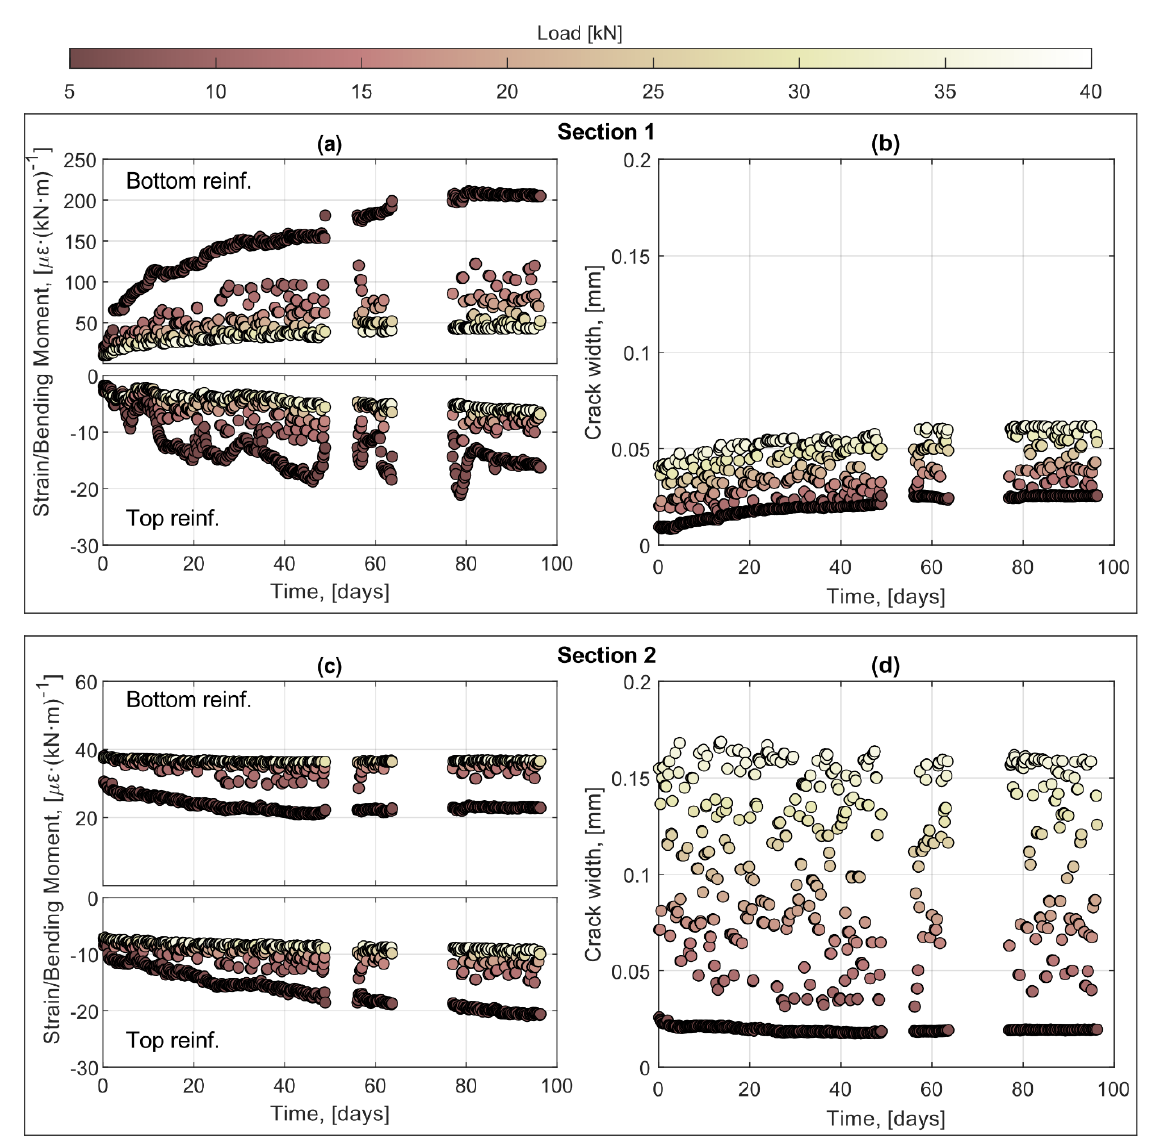
Figure 9. Evolution of strains over time represented as the ratio between the DOFS strain measurement and the section bending moment and evolution of crack width for Section 1 ( a , b ) and Section 2 ( c , d ).